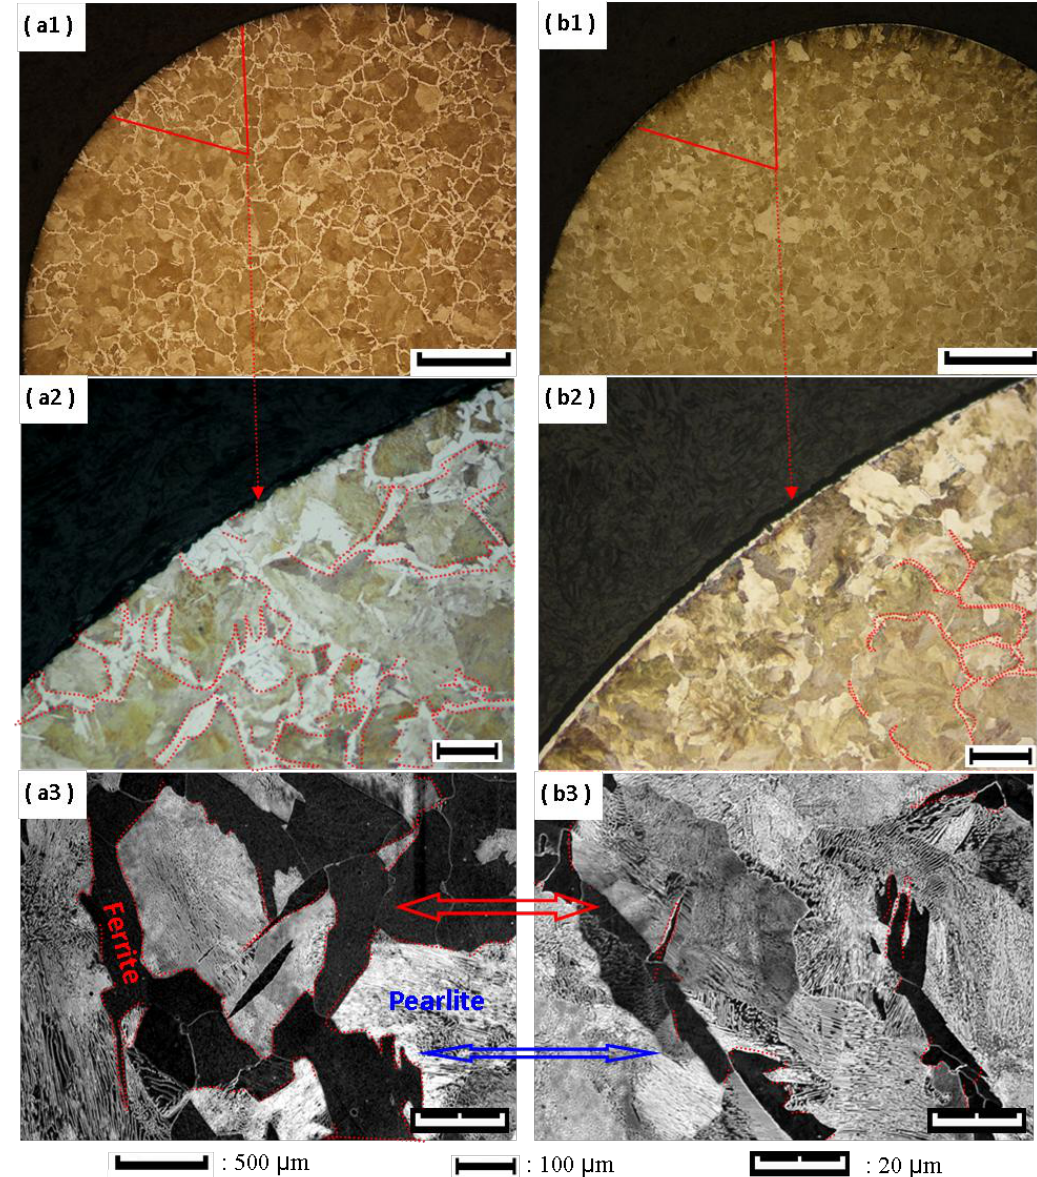
Figure 4. ( a1 – a3 ) Microstructure for the reference steel sample under magnifications of 50 × , 500 × , and 3000 × . ( b1 – b3 ) Microstructure for the as-carburized steel sample under magnifications of 50 × , 500 × , and 3000 × .